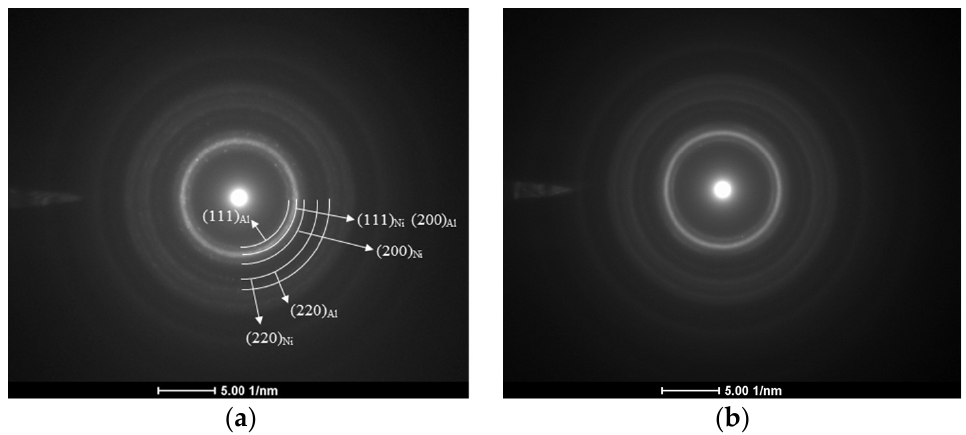
Figure 5. Selected area electron diffraction (SAED) pattern of Al/Ni (V) films with Λ = 25 nm: ( a ) ion gun off; ( b ) ion gun on.